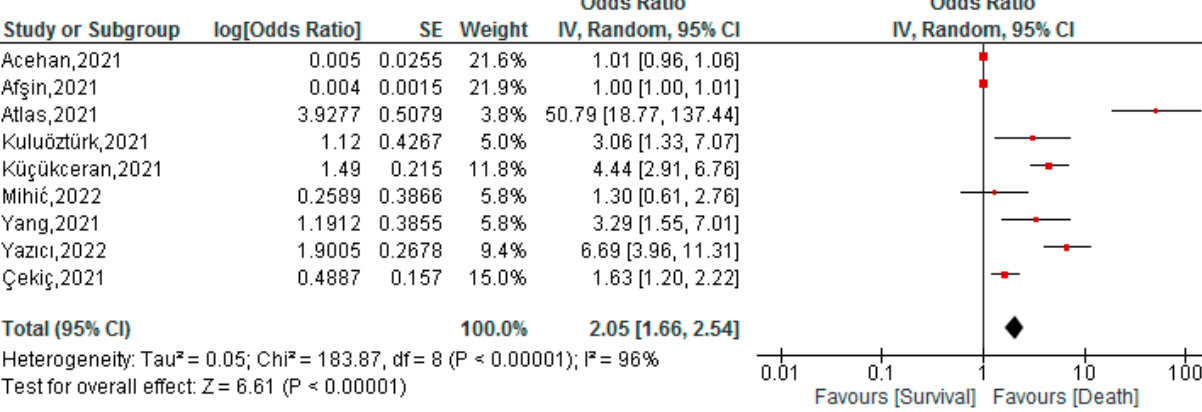
Figure 4. Association between BAR and severity of COVID-19 patients